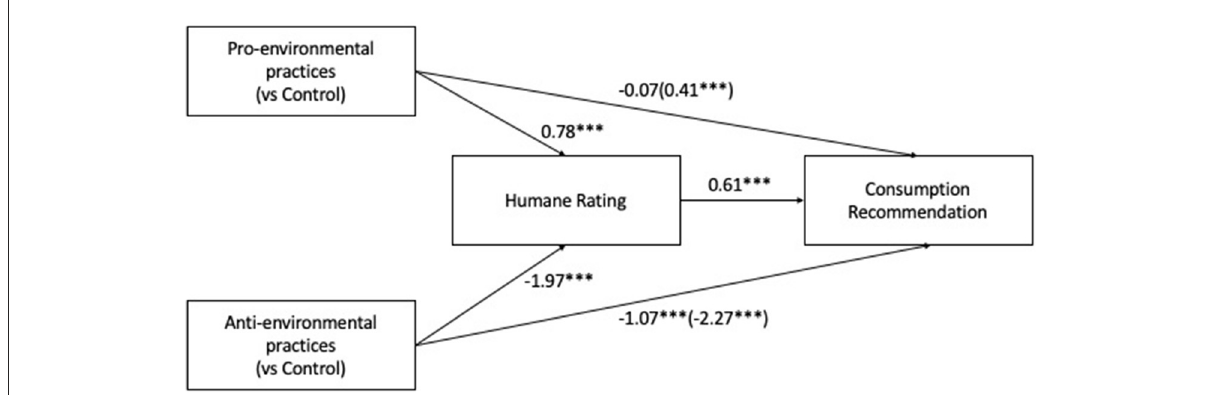
FIGURE2 Model testing whether judgments about a dairy’s treatment of its cows mediate the effect of environmental ethics information on consumption recommendations. The model accounted for 49% of the variance in consumption recommendations ( R 2 = 0.49). Numbers in parentheses indicate direct effects without inclusion of the mediator in the model. Asterisks indicate significant differences versus the control condition, *** p <